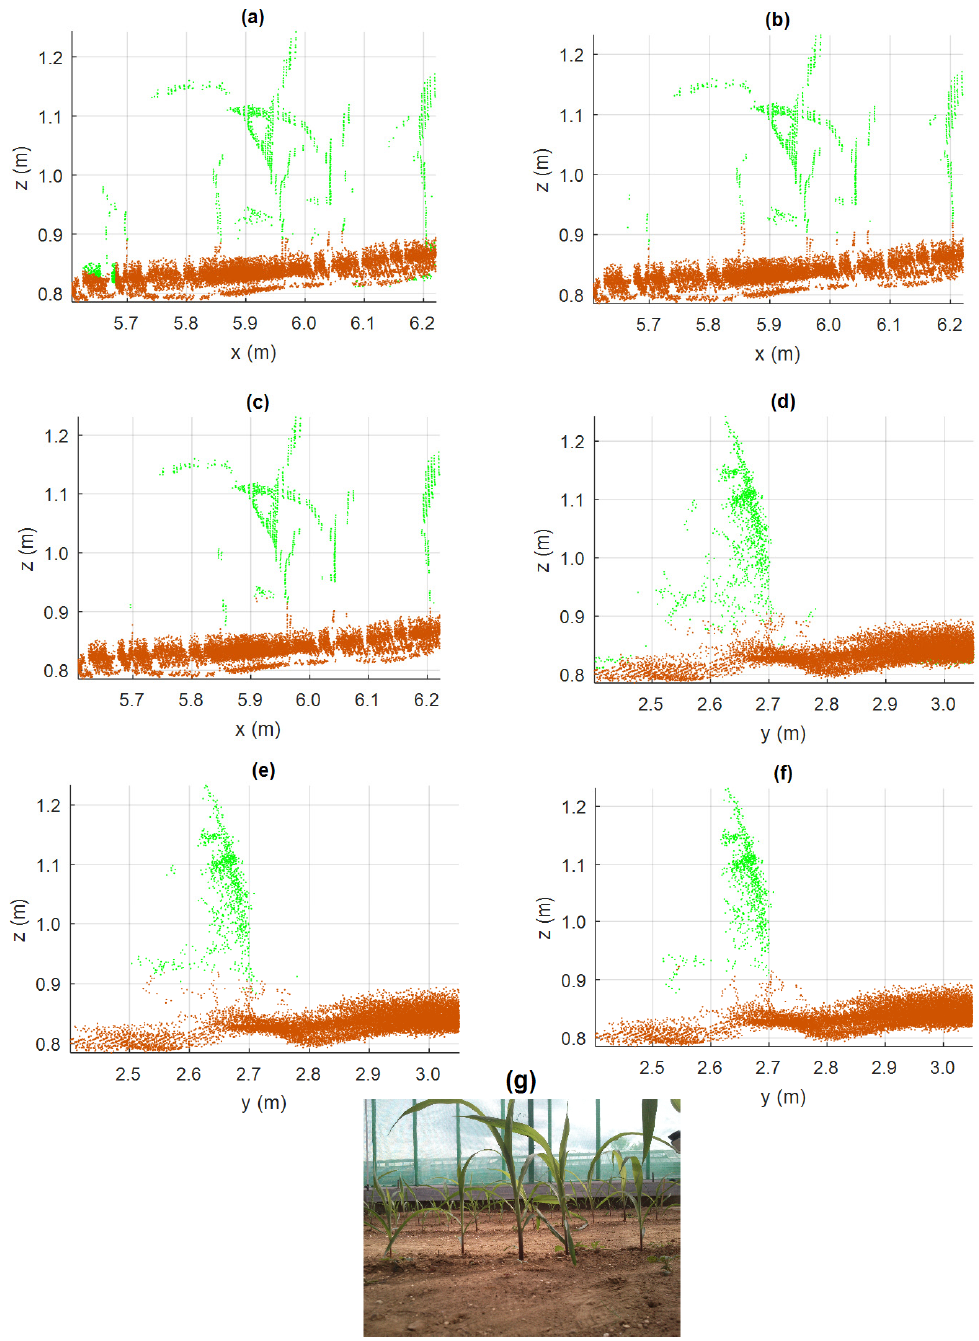
Figure 7. Plants reconstruction during vertical orientation noise removal filter evaluation. ( a – c ) XZ view considering five, 10, and 20 nearest neighbor points. ( d – f ) YZ view considering five, 10, and 20 nearest neighbor points. ( g ) Image of the front view of the plants.